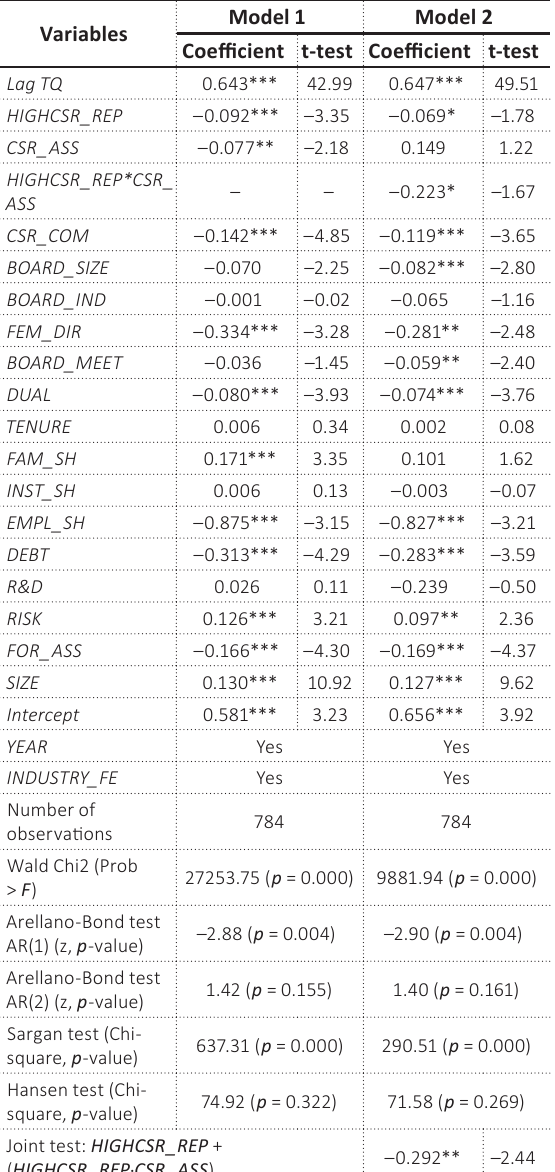
Table 3. Regression of Tobin’s q on high